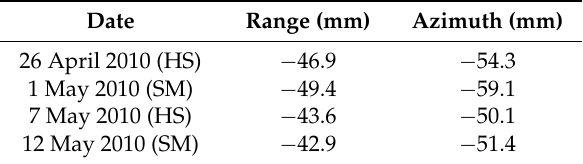
Figure 14. The assimilation results and their corresponding mean absolute error of periodic motion at point CR14 from February 2009 to April 2010; among them ( a , b ) were assimilation and simulation results from SM mode stack in range and azimuth separately with ( a’ , b’ ) as the corresponding mean absolute error; ( c , d ) were assimilation and simulation results from HS mode stack in range and azimuth separately with ( c’ , d’ ) as the corresponding mean absolute error. Table 4. A short term forecast of the periodic term